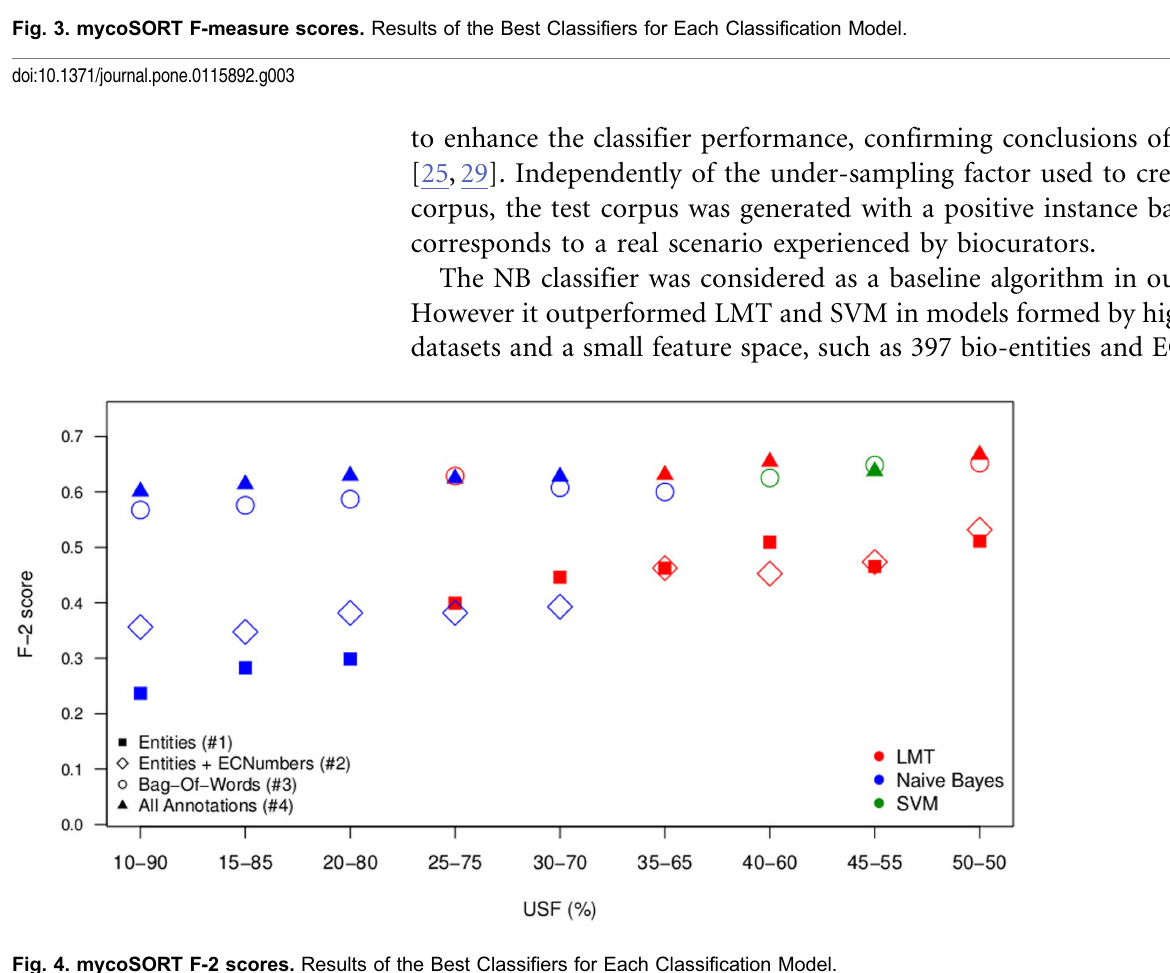
Fig. 4. mycoSORT F-2 scores. Results of the Best Classifiers for Each Classification